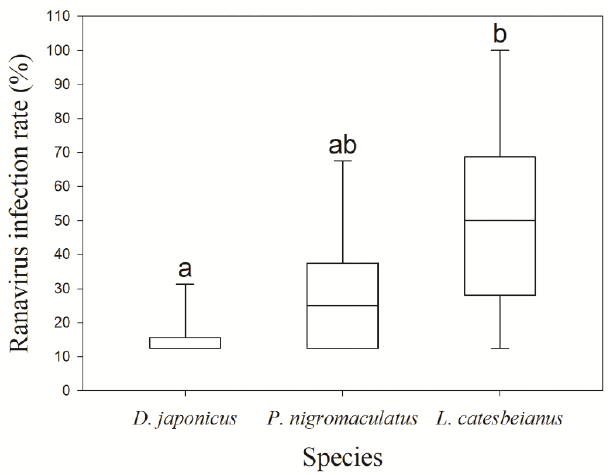
Figure 2. Box plots (medians ± quartiles) of the ranavirus infection rates among larvae of three anuran species ( Dryophytes japonicus , Pelophylax nigromaculatus , Lithobates catesbeianus ). The different characters on the bars between species indicate significantly different rates using the Kruskal–Wallis test with the Dunn-Bonferroni post hoc test ( p = 0.001).